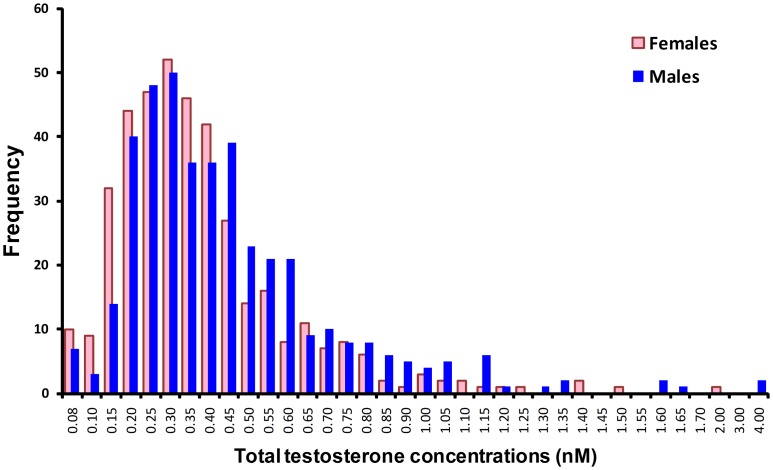
Frequency distribution of total testosterone (TT) values in male and female cord blood samples (n = 803).